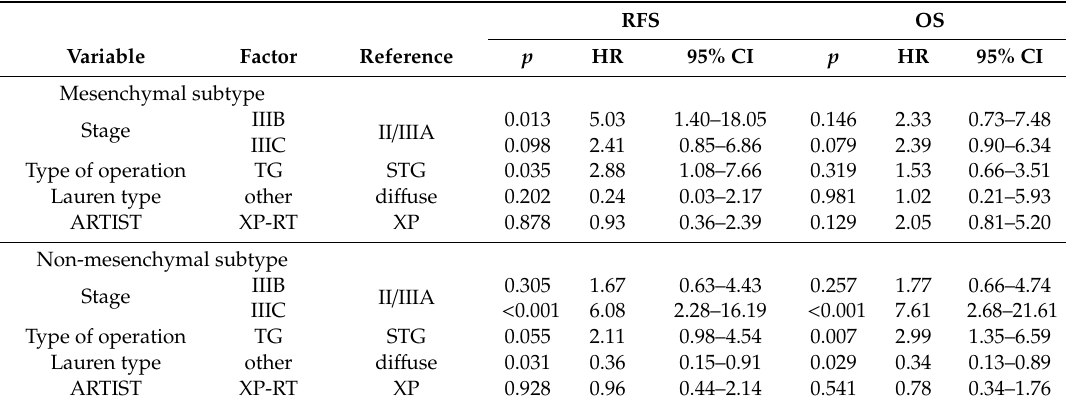
Table 3. Multivariate analysis of recurrence-free survival (RFS), and overall survival (OS) in mesenchymal and non-mesenchymal